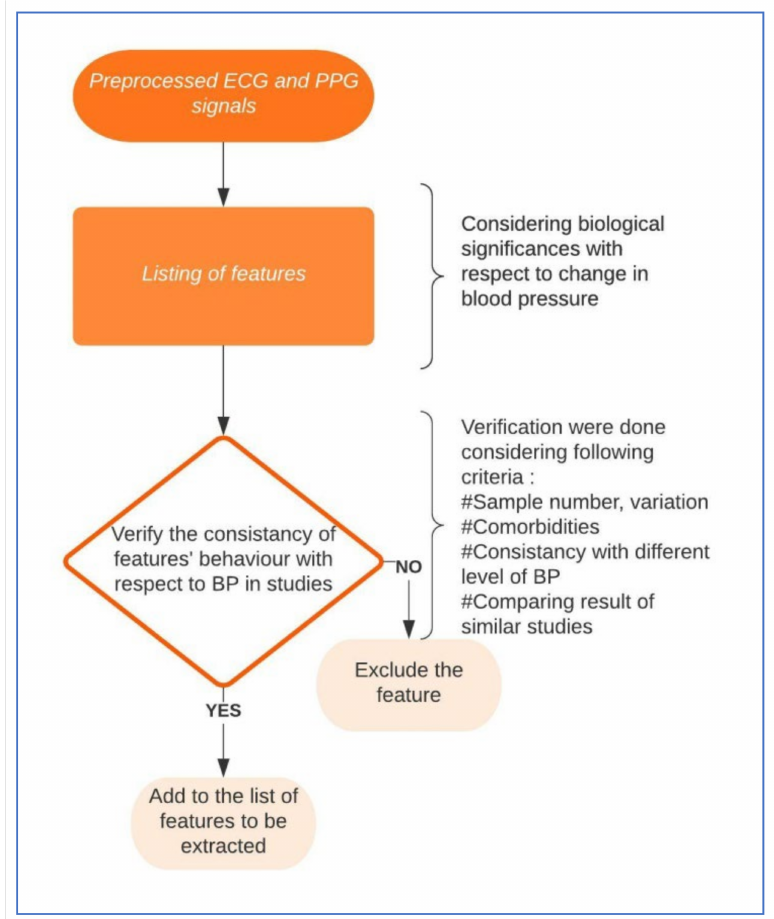
Figure 7. Diagram with the steps to finalize the features extraction